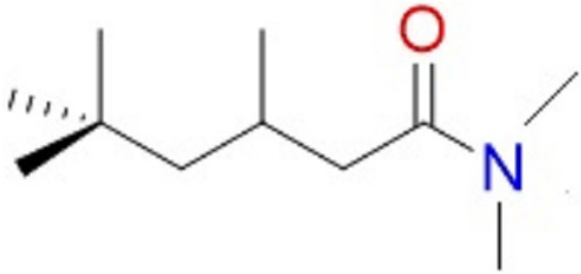
Figure 4. Molecular structure of tertiary (3°) organic amide.